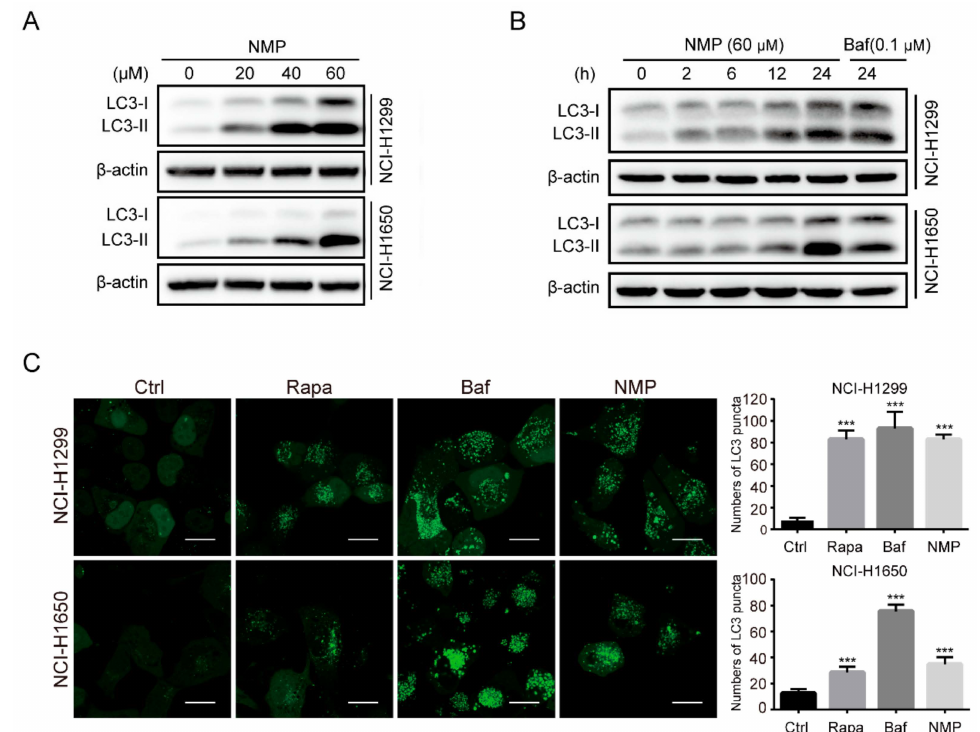
Figure 6. NMP induced the accumulation of autophagosomes in NSCLC Cells. ( A , B ) Western blot analyses for LC3II of dose-dependent (24 h treatment, ( A )) or time-dependent responses ( B ) in NCI-H1299 and NCI-H1650 cells treated with NMP (60 µ M) or bafilomycin A1 (Baf, 0.1 µ M). ( C ) Fluorescence micrographs of LC3-stably-expressed NCI-H1299 and NCI-H1650 cells treated with vehicle, rapamycin (Rapa, 0.5 µ M), bafilomycin A1 (Baf, 0.1 µ M) or NMP (40 µ M). Scale bar, 20 µ m. Error bars mean ± S.D. of three independent experiments; *** p < 0.001, compared to the control